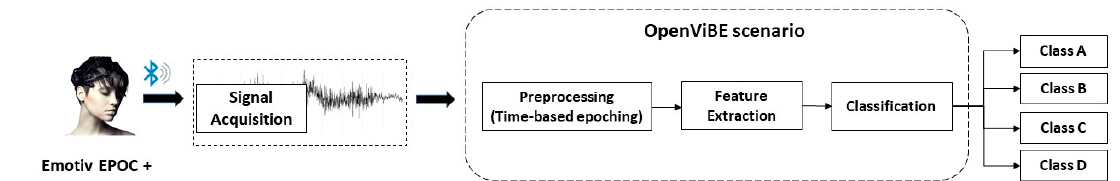
Figure 1. Flowchart of the proposed BCI system.